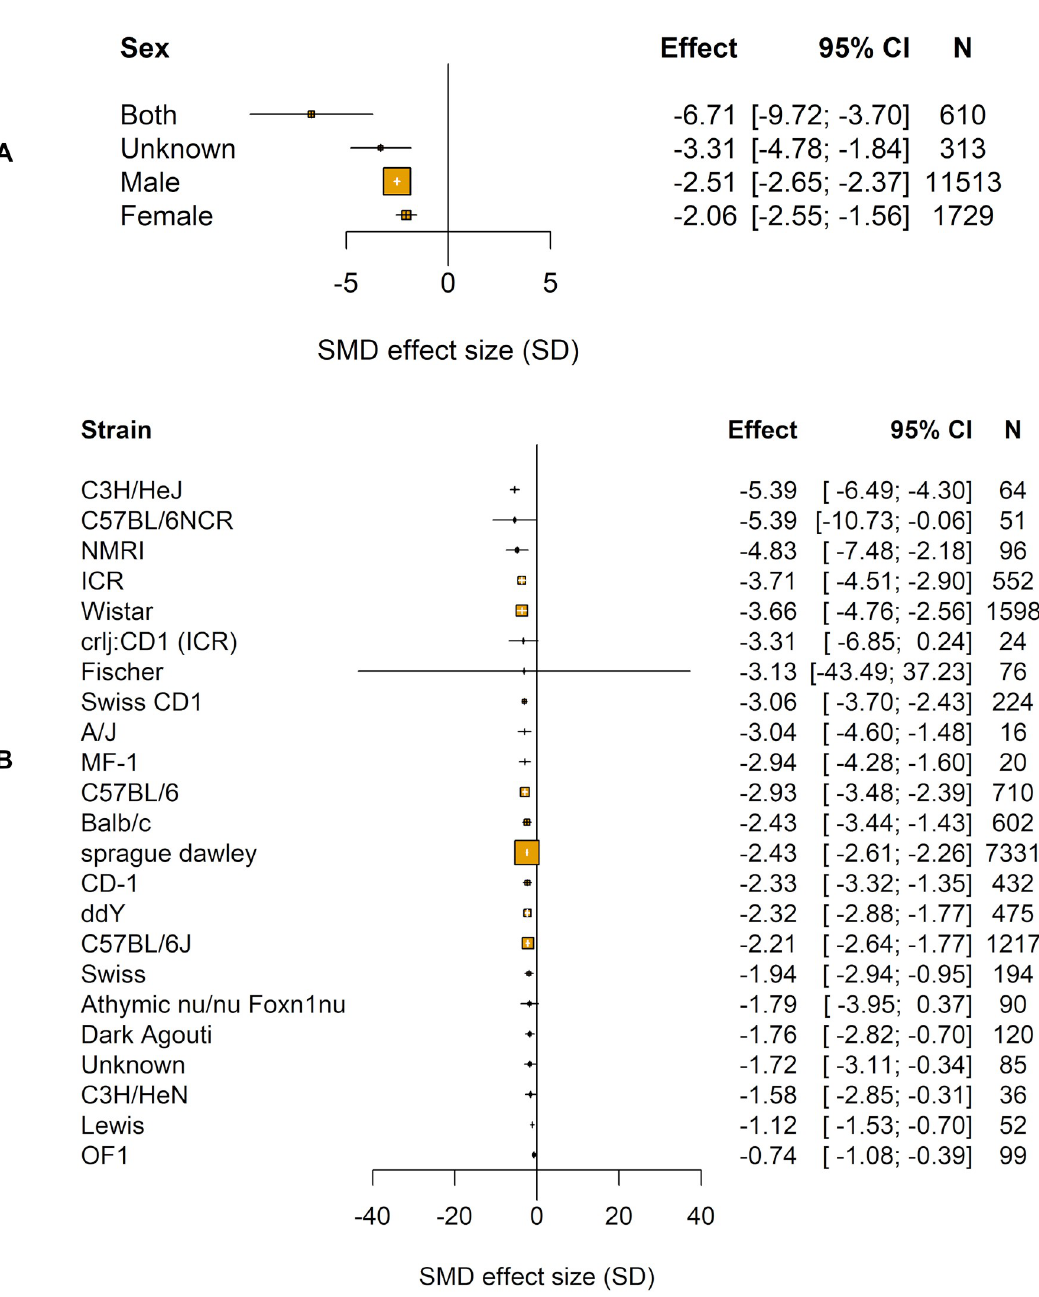
Fig 4. Impact of study design in modelling experiments using pain-related behavioural outcomes (data set 1a). The size of the squares represents the number of nested comparisons that contribute to that data point, and the value N represents the number of animals that contribute to that data point. (A) Sex accounted for a significant proportion of the heterogeneity. (B) Strain accounted for a significant proportion of the heterogeneity. SMD, standardised mean difference.